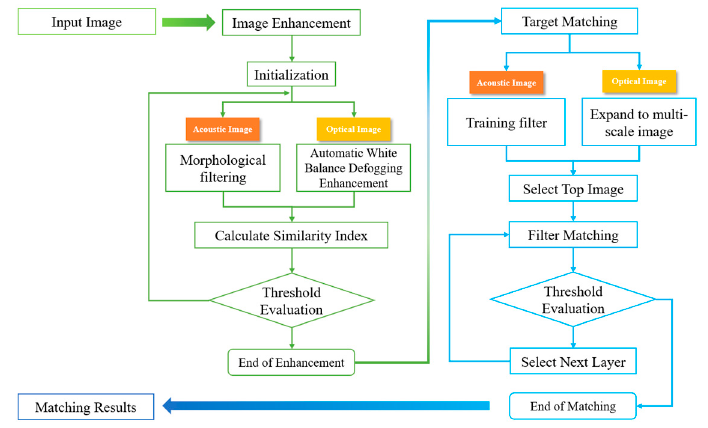
Figure 1. Overall framework of matching algorithm.